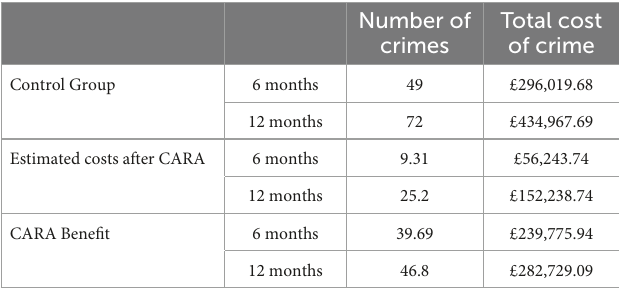
TABLE 12 Economic benefits of the CARA service (West Midlands